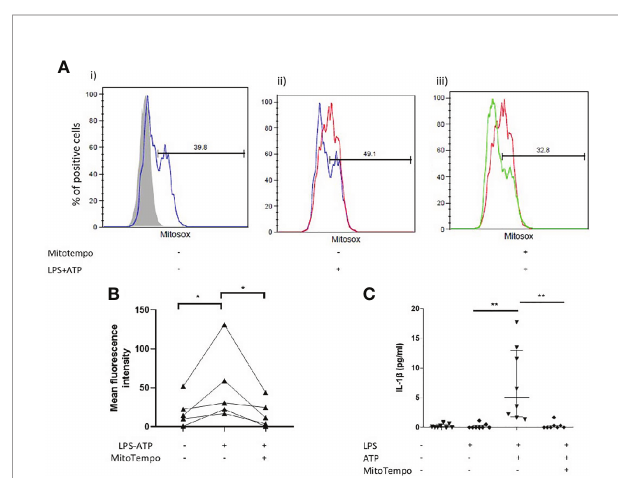
FIGURE 4 | Mitochondrial antioxidant treatment effect on in fl ammasome activation. AMs were treated with MitoTempo (100 m M), a mitochondrial antioxidant for 1 hour prior to the addition of ATP. Cells were subsequently treated with ATP for 30minutes. (A) Representative histograms of freshly isolated AMs from ILD subjects, labelled with CD45-FITC and MitoSOX Red analysed by fl owcytometry. AMs were selected and percentage of MitoSOX positive cells and mean fl uorescence intensities were analysed relative to CD45-FITC labelled populations (grey histograms). AMs were either left untreated(i), treated with (ii) LPS/ATP for NLRP3 activation or (iii) MitoTempo and LPS/ATP. (B) MitoSox (assessed by fl ow-cytometry) and (C) IL-1 b release measured at baseline, after NLRP3 activation and after NLRP3 activation in the presence of MitoTempo (100 m M), Data presented as median with interquartile range, *p<0.05 **p<0.005, Paired Wilcoxon